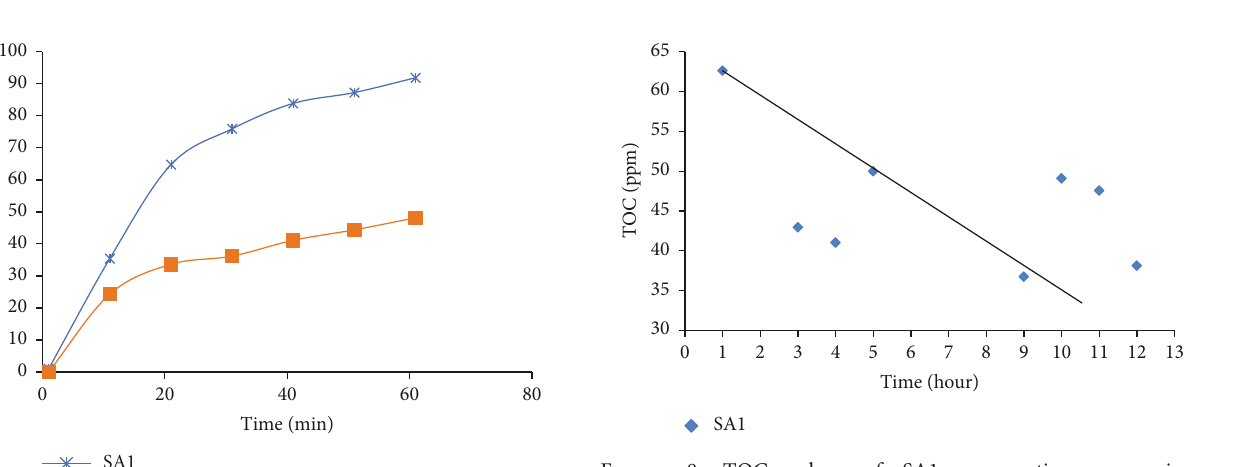
Figure 8: TOC values of SA1 versus time comparison photodegradation of paraquat (100ppm) under